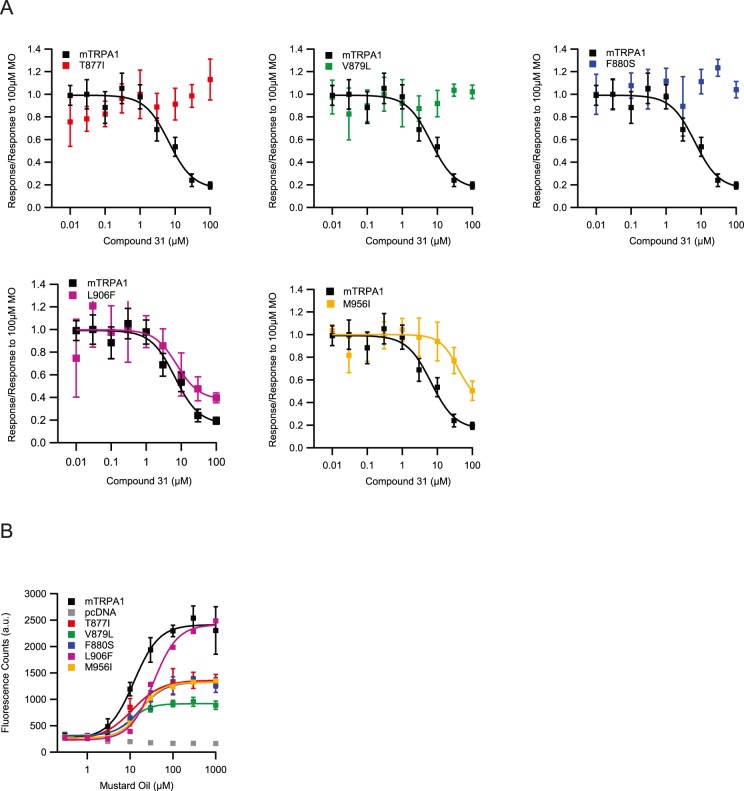
Single-point mutations reduce inhibition by Compound 31.A) Concentration-response curves of wild-type TRPA1 and single-point mutants obtained from pre-incubation of Compound 31 and subsequent stimulation by 100 µM mustard-oil. All curves are normalized to maximal responses evoked by mustard-oil in the absence of Compound 31. Error bars are stdv., n = 6. Lines are fits of Hill-equations to the data. B) Concentration-response curves of wild-type TRPA1, pcDNA and single-point mutants to mustard-oil (final concentrations). Error bars are stdv., n = 4. Lines are fits of Hill-equations to the data.